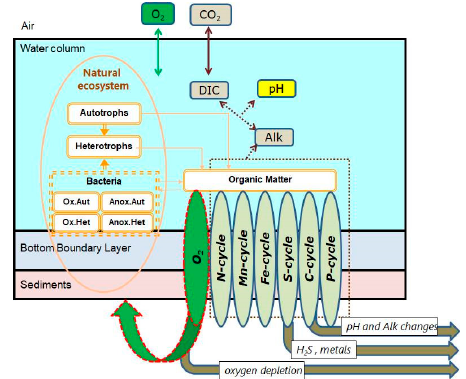
Figure 1. Schematic representation of the benthic redox model (BROM) biogeochemical processes considered and the model’ domain.